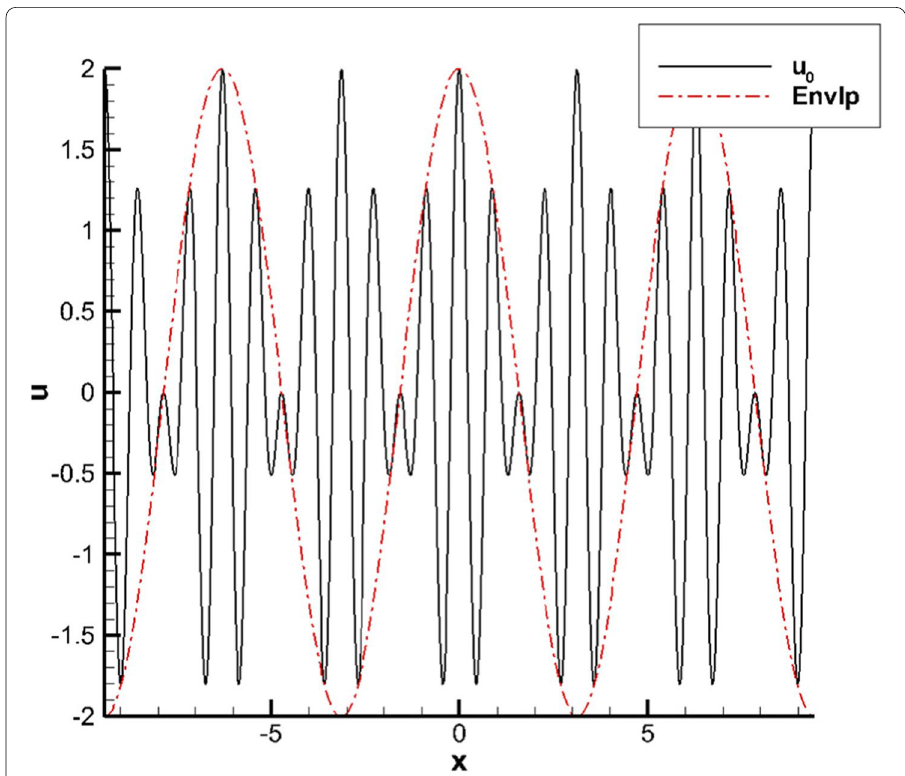
Fig. 10 Distributions of initial combination wave and its envelope for k 1